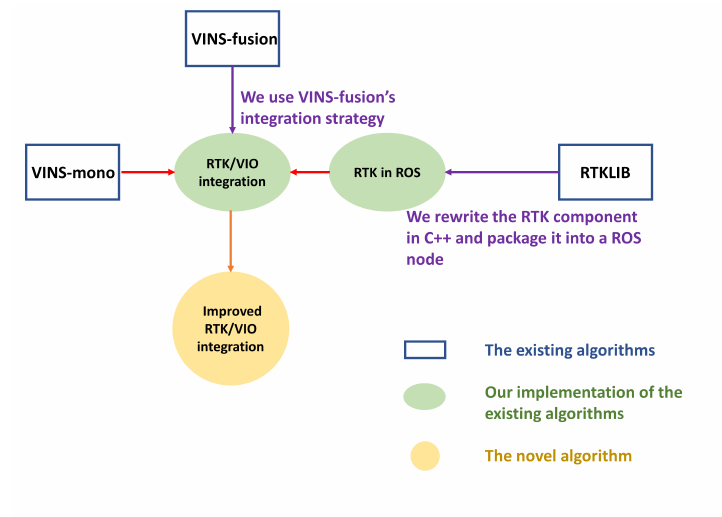
Figure 1. The relationship between the existing algorithms and our